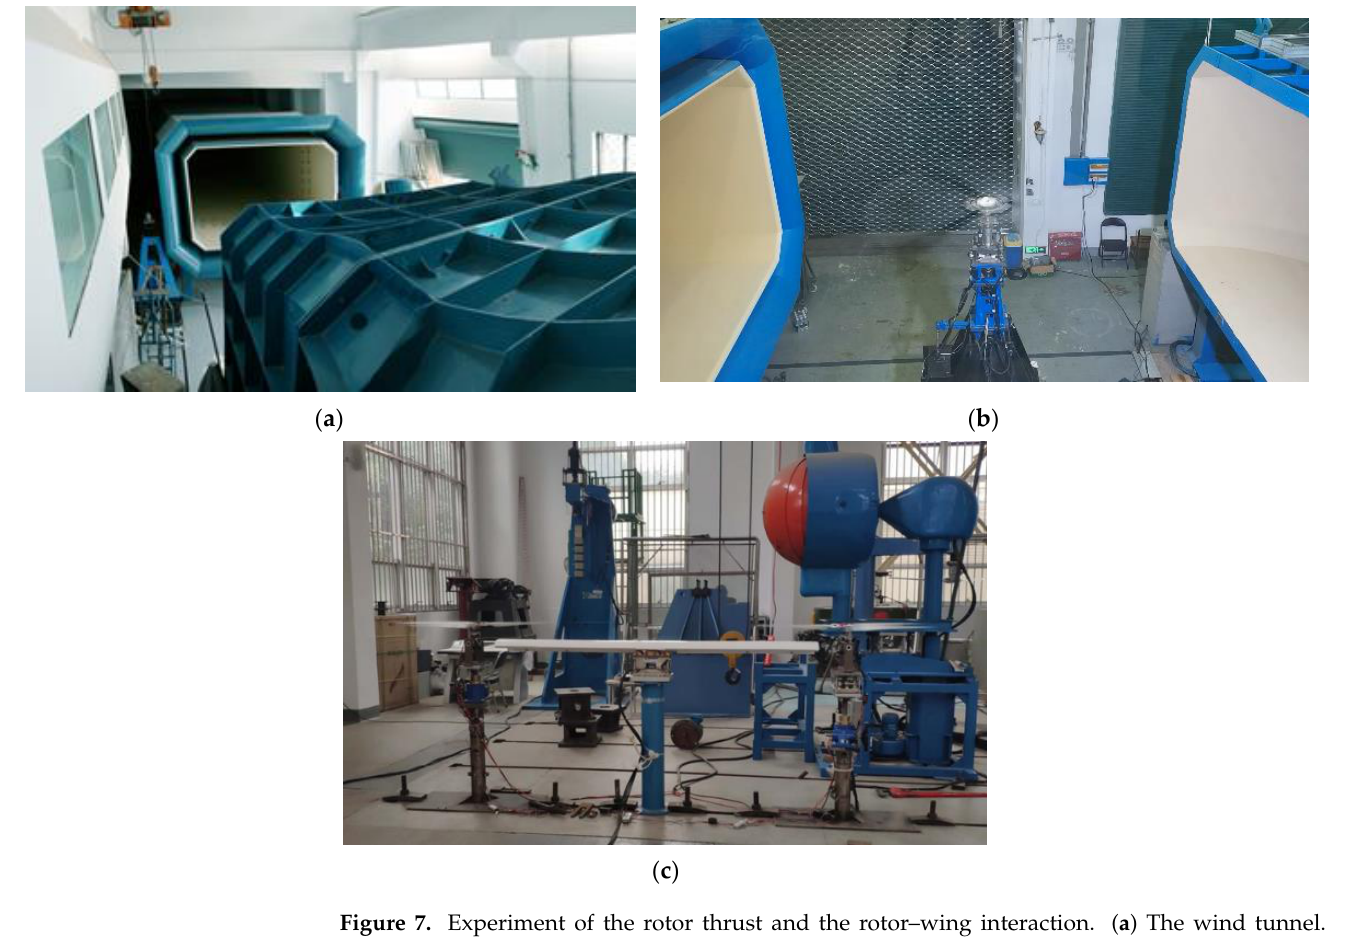
Figure 7. Experiment of the rotor thrust and the rotor – wing interaction. ( a ) The wind tunnel. ( b ) Experiment of the rotor thrust. ( c ) Experiment of the rotor – wing interaction.